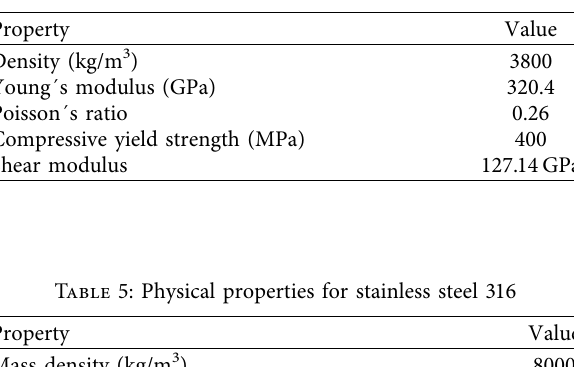
Table 4: Mechanical and physical properties of Al